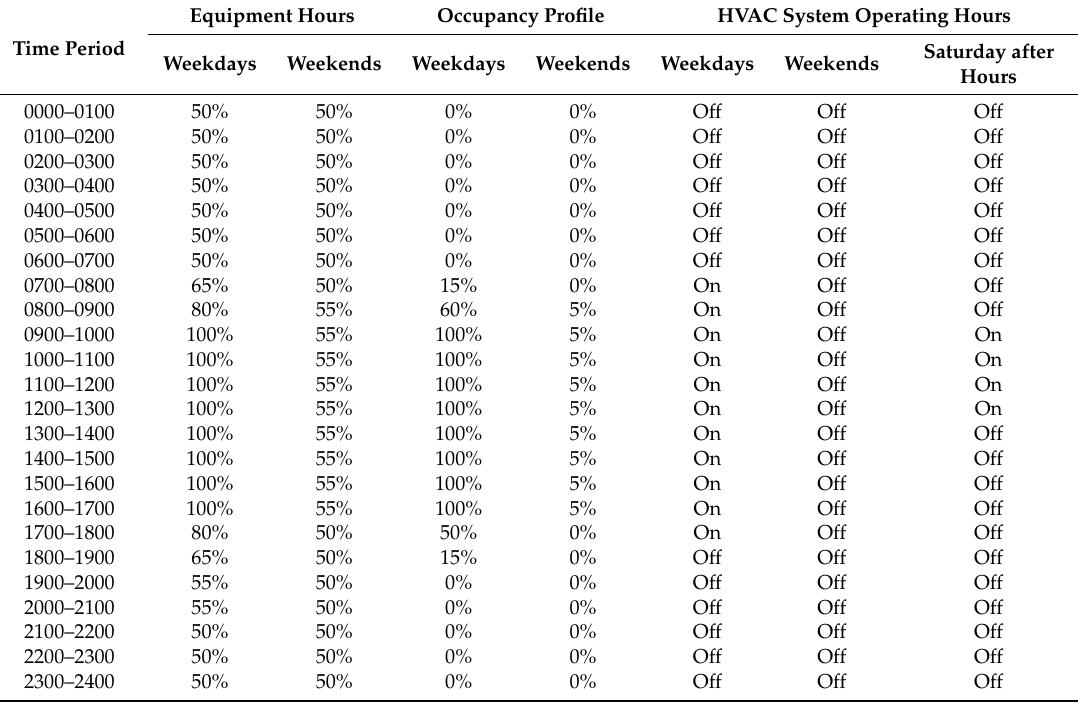
Table 3. Equipment, occupant and HVAC system profiles utilized in the current study